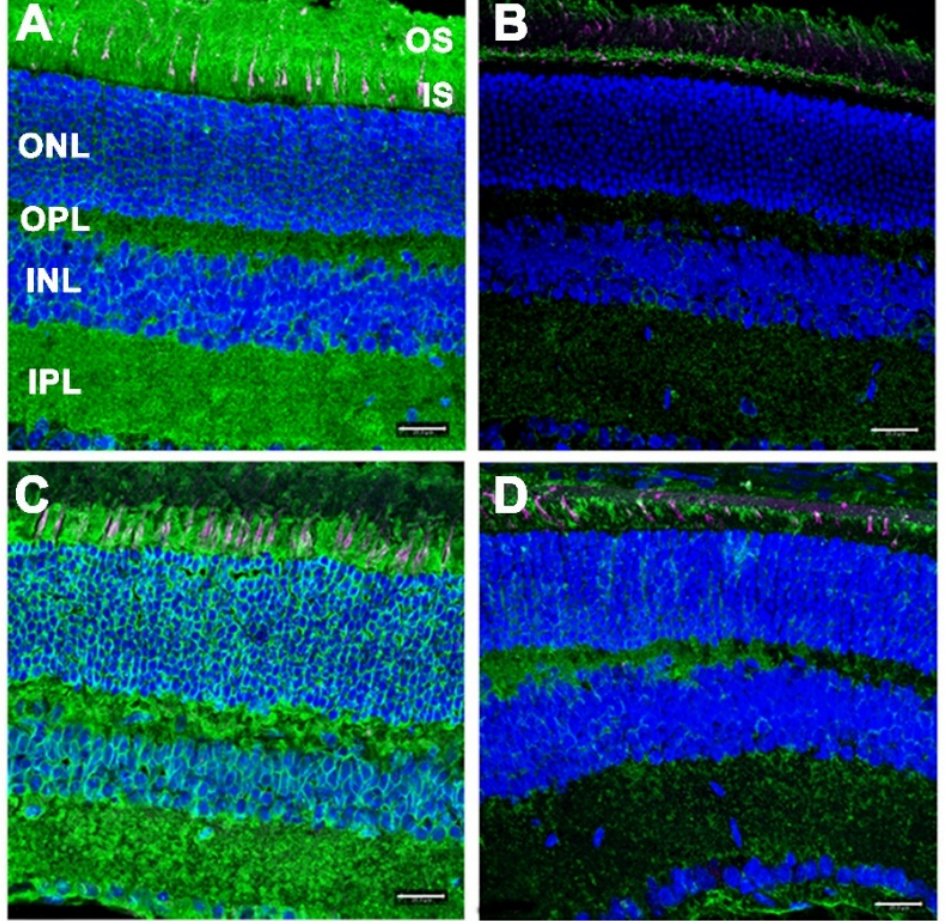
Figure 5. ConA lectin cytochemical analysis of retinas from ( A , B ) WT control and ( C , D ) Dhdds K42E / K42E mice at PN 6 months of age, with ( B , D ) or without ( A , C ) pretreatment with PNGase-F. ConA binding (green); PNA binding (magenta); DAPI counterstain (blue). Abbreviations are the same as in the Figure 4 legend. Scale bar (all panels): 20 μ m.